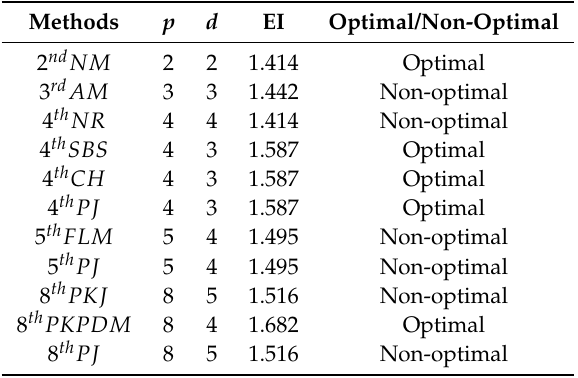
Table 1. Comparison of Efficiency Indices (EI) and